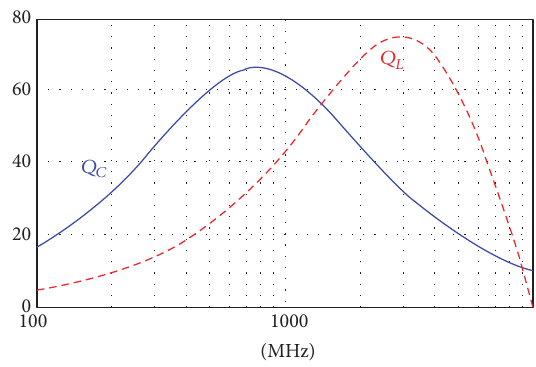
Figure15:Qualityfactor 𝑄 𝐿 ofthediagonalentriesoftheimpedance matrix Z 𝐿 and quality factor 𝑄 𝐶 of all entries of the admittance matrix Y 𝐶 , for the antenna tuner of Section 7.